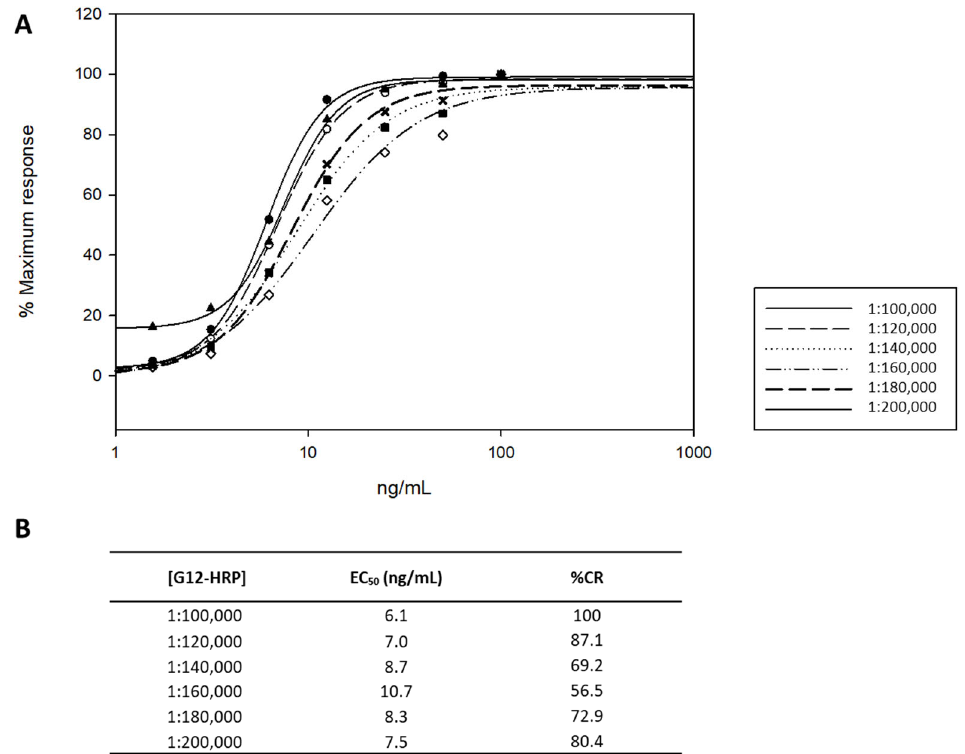
Figure 1. G12-HRP moAb titration for sandwich ELISA optimization. ( A ). Relative affinity of G12-HRP moAb for 33-mer peptide. ( B ). Standard reference curves. EC 50 and cross-reactivity (CR) were obtained by G12 ELISA. EC 50 is the line concentration that reduces the maximum absorbance by 50% in the assay. CR was calculated as follows: (EC 50 of the antigen for which the moAb was raised/EC 50 of each antigen assayed) × 100. These assays were performed in duplicate moAb, monoclonal antibody.